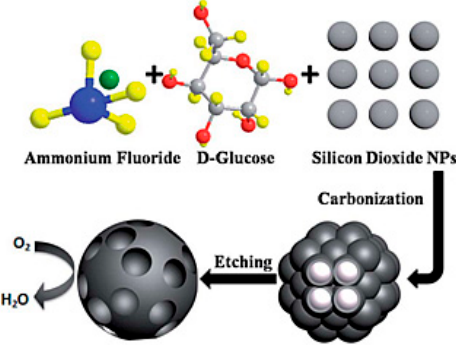
Figure 10. Schematic diagram for the synthesis of Si-F-doped porous carbon material. (Reproduced from [143] with permission of The Royal Society of Chemistry).